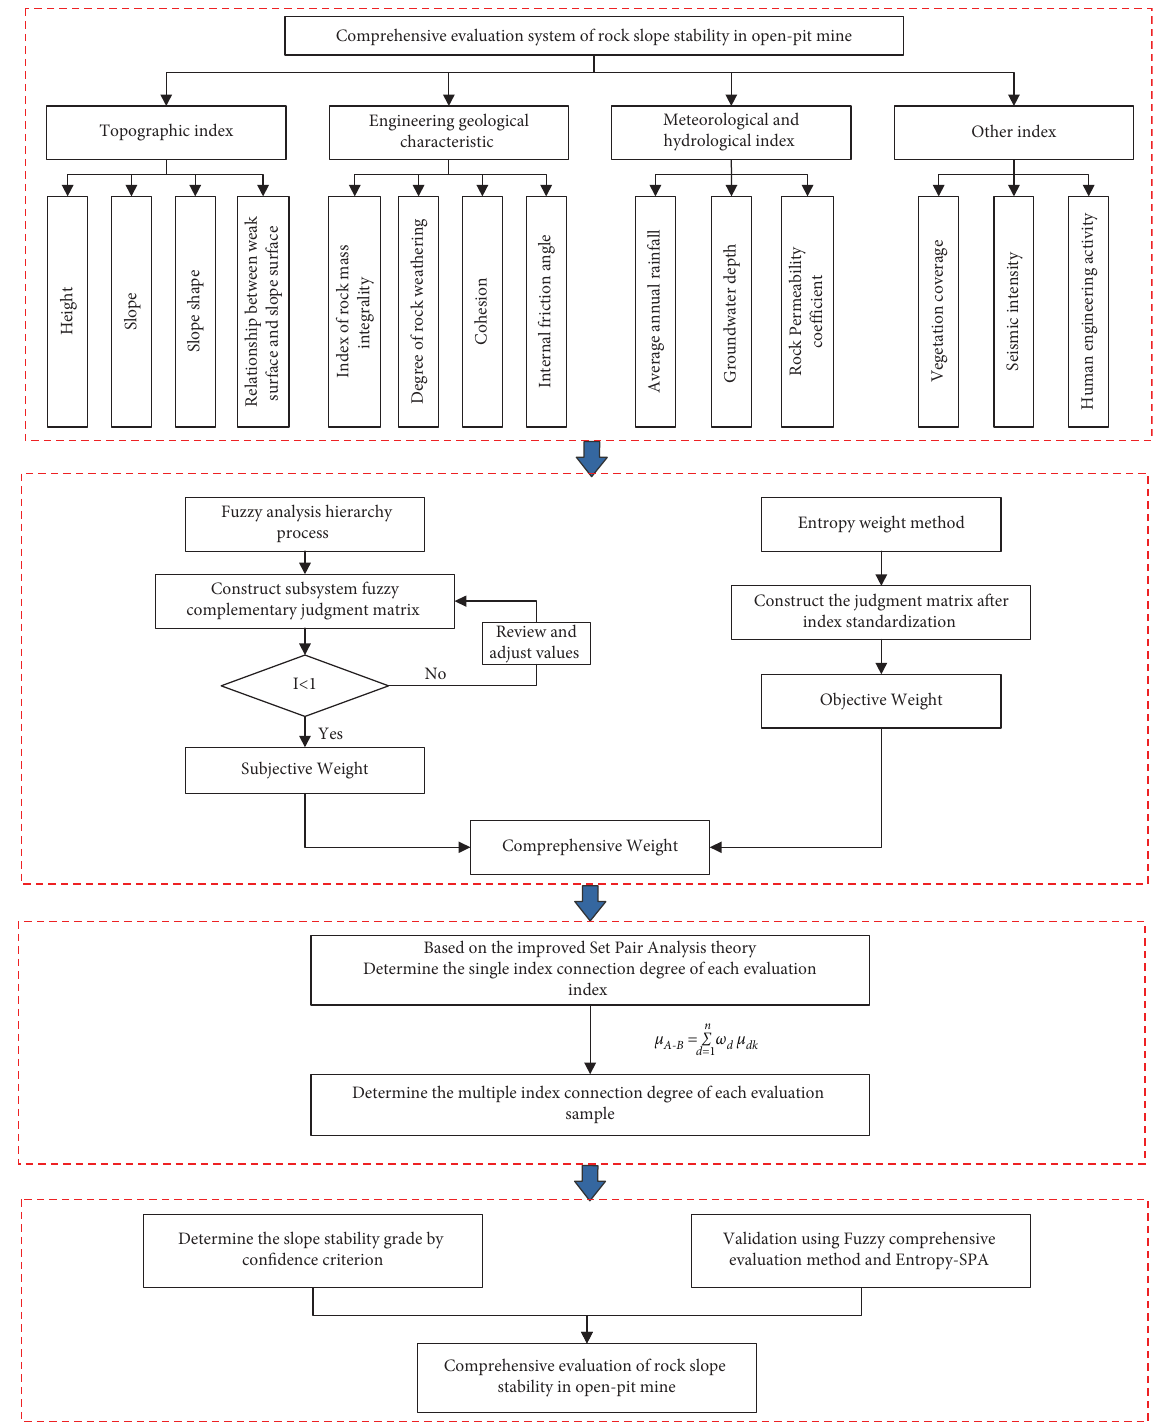
Figure 3: Flow chart of comprehensive evaluation of open-pit slope stability based on EFAHP-SPA